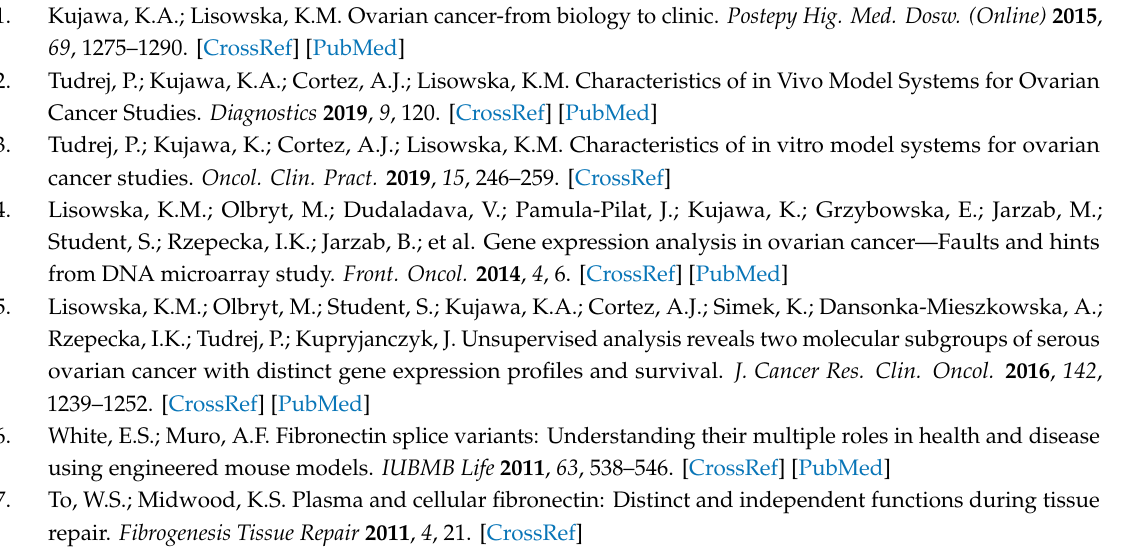
Figure S2: A. Examples of specimens derived from omental metastatic disease with strong fibronectin expression (paired IHC and H&E images); B. Examples of specimens containing ovarian structures (paired IHC and H&E images), Figure S3: Immunohistochemical detection of periostin in cancer cells and in tumor stroma (paired IHC and H&E images), Figure S4: Kaplan-Meier analysis of overall survival (OS) and disease-free survival (DFS) in 108 patients in regard to following clinico-pathological features: age, grade, TP53 accumulation, degree of desmoplastic reaction, type of tumor growth (papillary versus solid versus mixed), inflammatory infiltration, calcifications in the tumor (all nonsignificant), Figure S5: Kaplan-Meier analysis of overall survival (OS) and disease-free survival (DFS) in 108 patients stratified by combined FN1&POSTN score, Table S1: Association between fibronectin expression and clinico-pathological features ( χ 2 test), Table S2: Association between periostin expression and clinico-pathological features ( χ 2